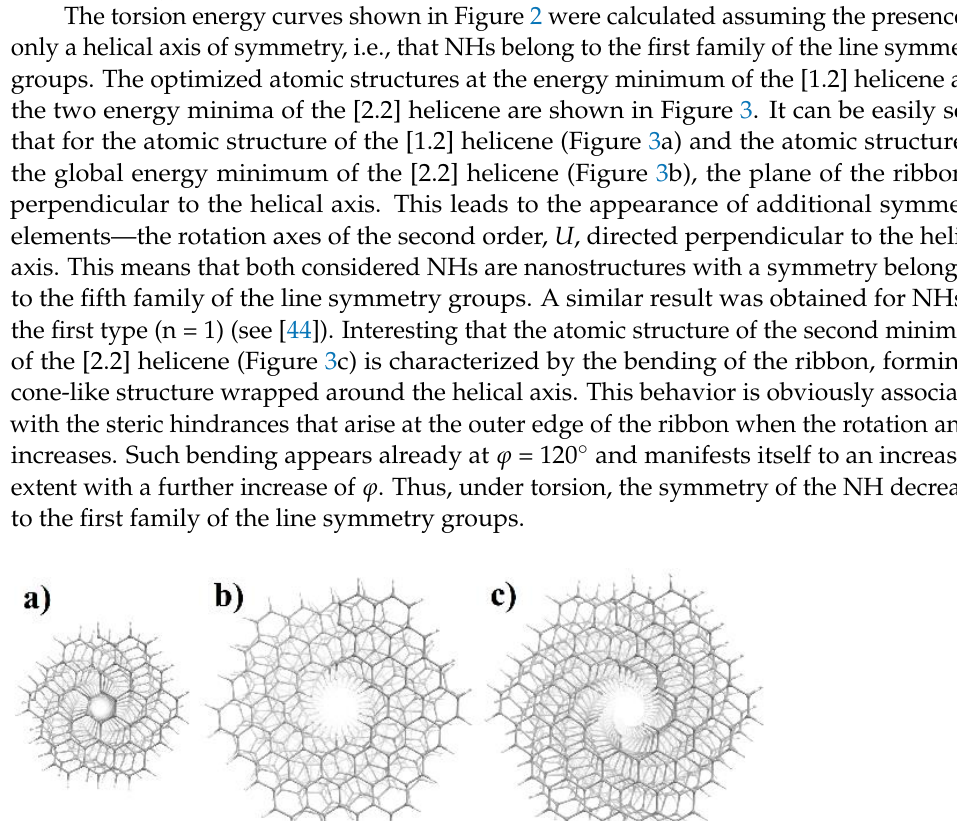
to the 5th family of the line groups. Torsion-induced symmetry breaking lowers the point symmetry of the monomer from D 1 to C 1 while the order of the helical axis is preserved. 3.2. Electronic and Magnetic Properties Figure 4 shows the total densities of the electronic states (DOS) for different states of the considered structures (with a rational Q ) closest to the energy global minima. The DOS of the states of the [2.2] helicene is expectedly more complicated than the DOS of states of the [1.2]helicene, but in all cases, Figure 4 shows the van Hove singularities that are typical for the Q1D systems. The values of the Fermi energy of metallic states are close for both NHs, but there is a difference. The Fermi level of the [1.2]NH mono is located in the middle of the area of high density in contrast to the Fermi level of the [2.2]NH mono . The ferromagnetic ordering shifts α -DOS towards lower energies, allowing the high-density region of the DOS to be com- pletely filled with an exc ess of α -spin electrons and determines the existence of the [1.2]NH ferro and the absence of the [2.2]NH ferro . Both types of MIT open an electronic band gap (BG) near the Fermi level. In both NHs, the BG, opened due to the Peierls MIT, is narrower than that due to the Mott – Hub- bard MIT. This becomes clear if we take into account the fact that the appearance of the BG corresponds to a decrease in the total energy, and the values of the BG can be a meas- ure of this decrease. The form of the DOS changes little under the MIT. These changes concern only the appearance of the BG. The changes in the rest of the DOS regions are also minimal, demon- strating that the electronic and atomic structures remain unchanged during the MIT.